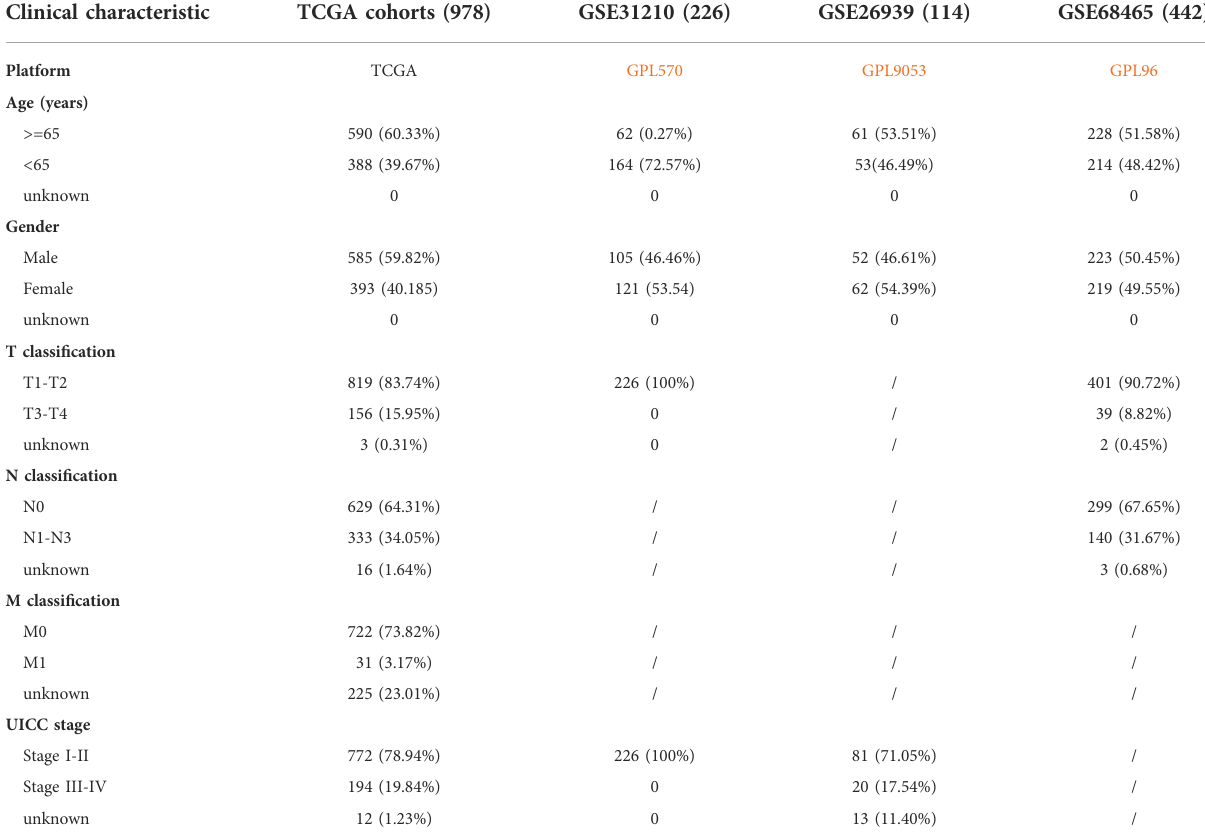
TABLE 1 Clinical features of patients from TCGA and GEO